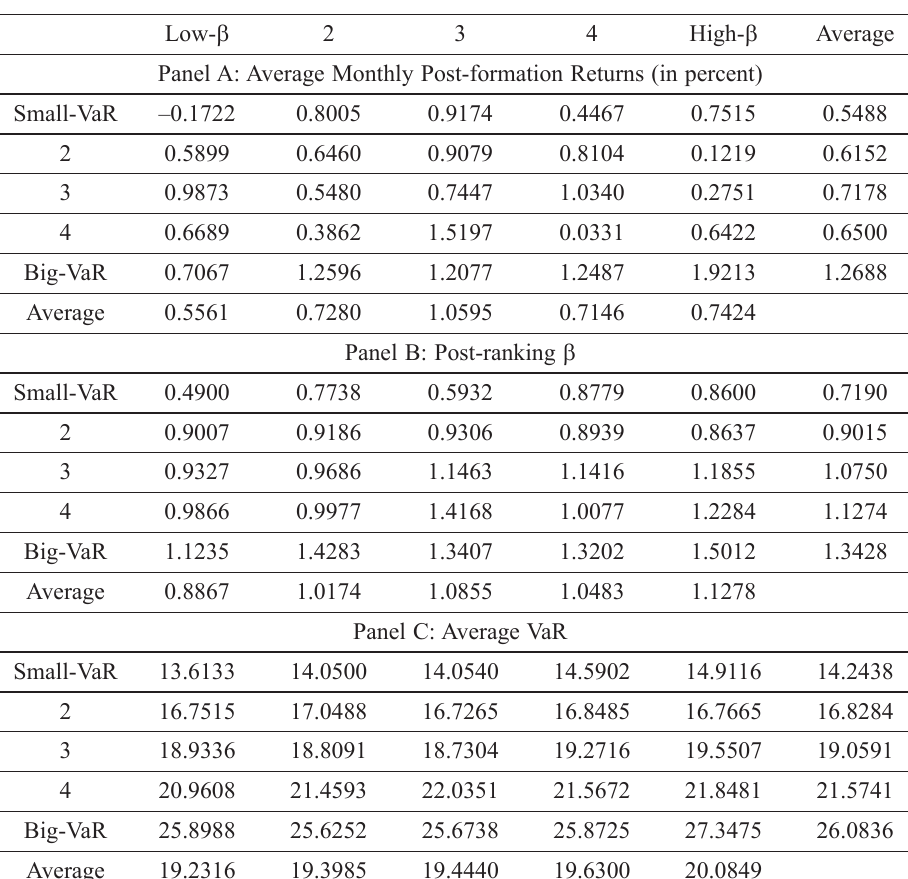
Table 5. Properties of portfolios formed on VaR and pre-ranking β : stocks sorted by VaR (down) then pre-ranking β (across), 1996–2009 Low-